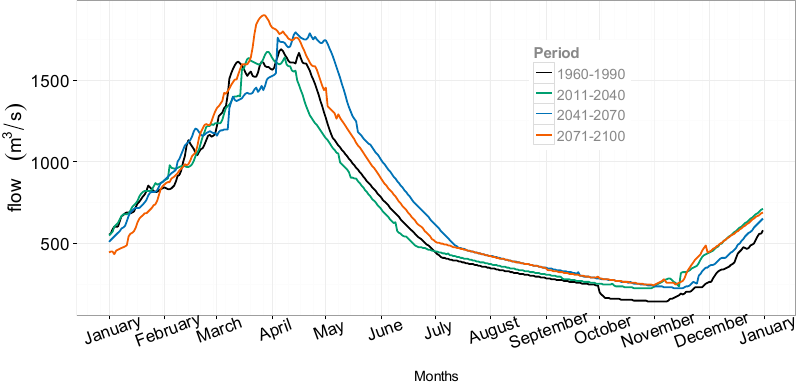
Figure 6. Changes in hydrological variables in Kwanza River Basin.